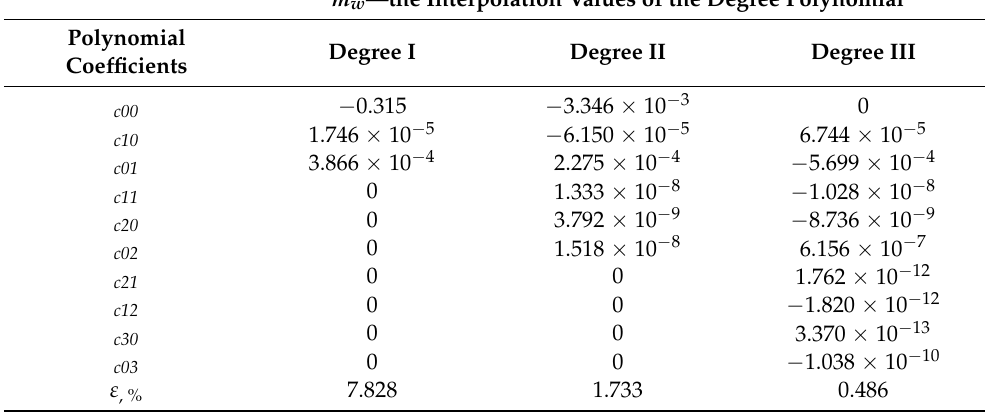
Table 3. Polynomial coefficients and the error for the parameter, m w. m w — the Interpolation Values of the Degree